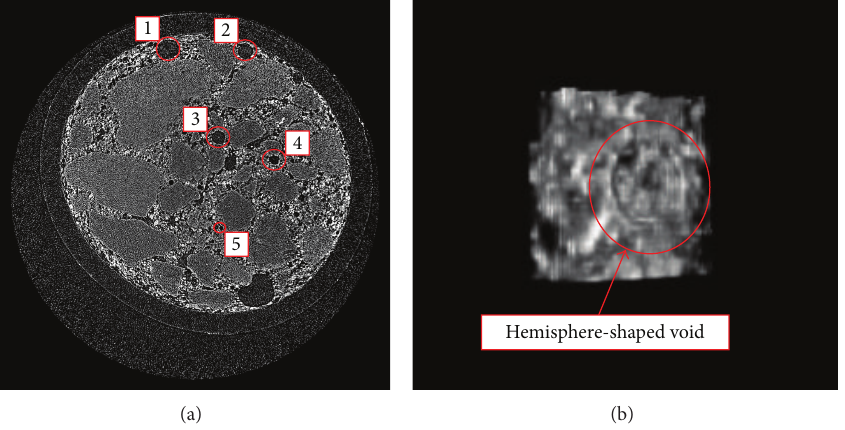
Figure 5: Region of voids and glass beads inside the insulating concrete specimen: (a) inner voids of the specimen (voids 1, 2, and 3: voids in cement, voids 4 and 5: candidates for glass bead) and (b) sample of 3D void image by glass bead.